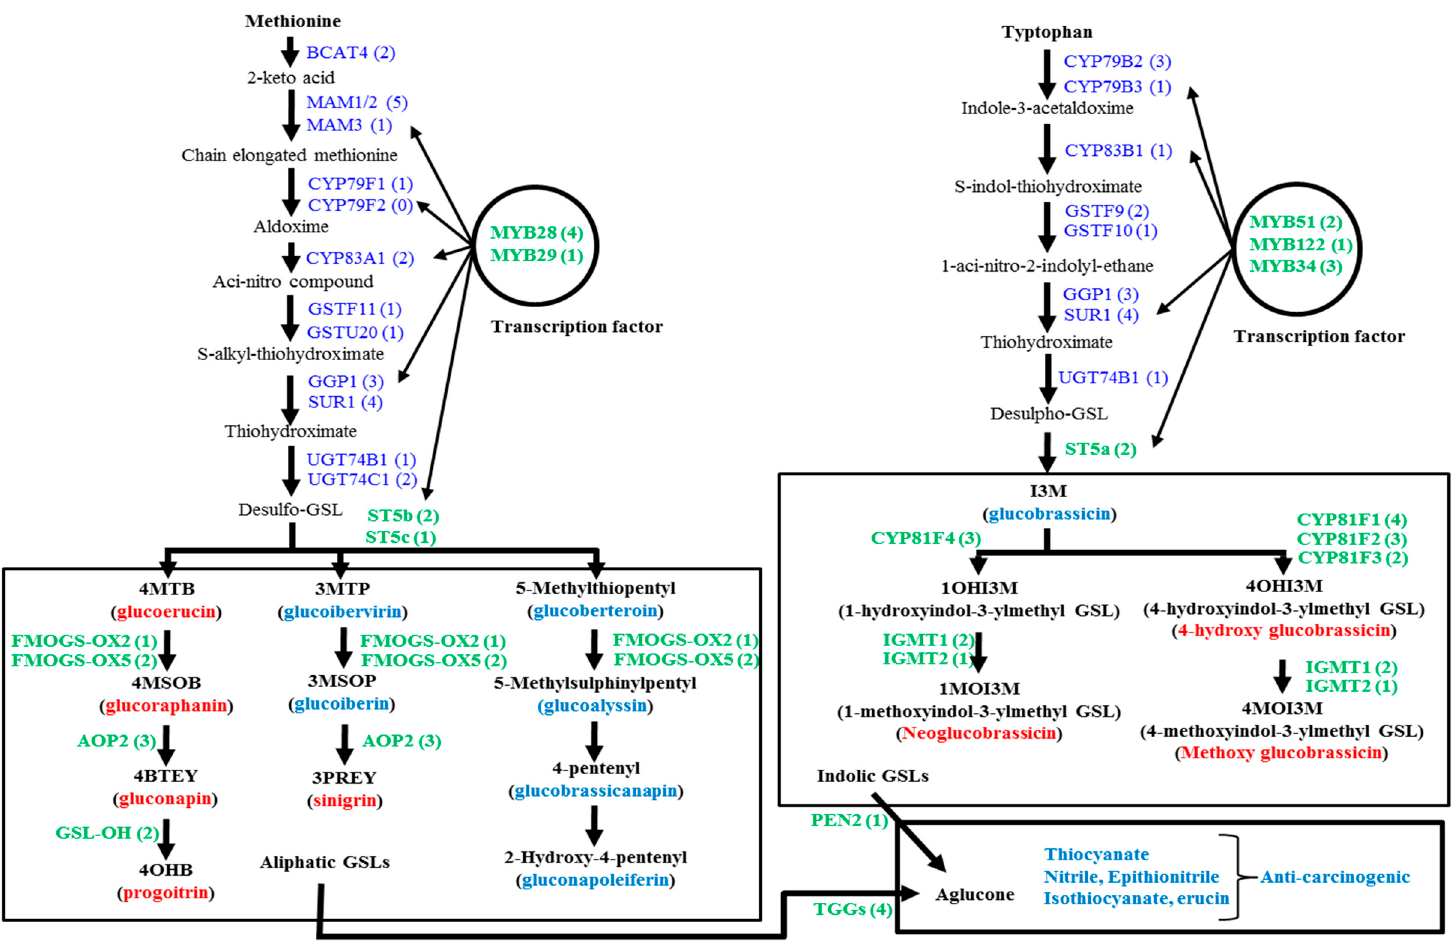
Figure 1. Metabolic pathways involved in the biosynthesis of aliphatic and indolic glucosinolates (GSL) after Liu et al . [10], along with the related genes of B. oleracea . The GSL molecules measured by HPLC are denoted as red bold (see Table S1 for their chemical structure names). The relative expression level of green bold genes was measured by qPCR. Numbers in parentheses denote the number of genes involved in this process (Adopted from Yi et al . [5]) .